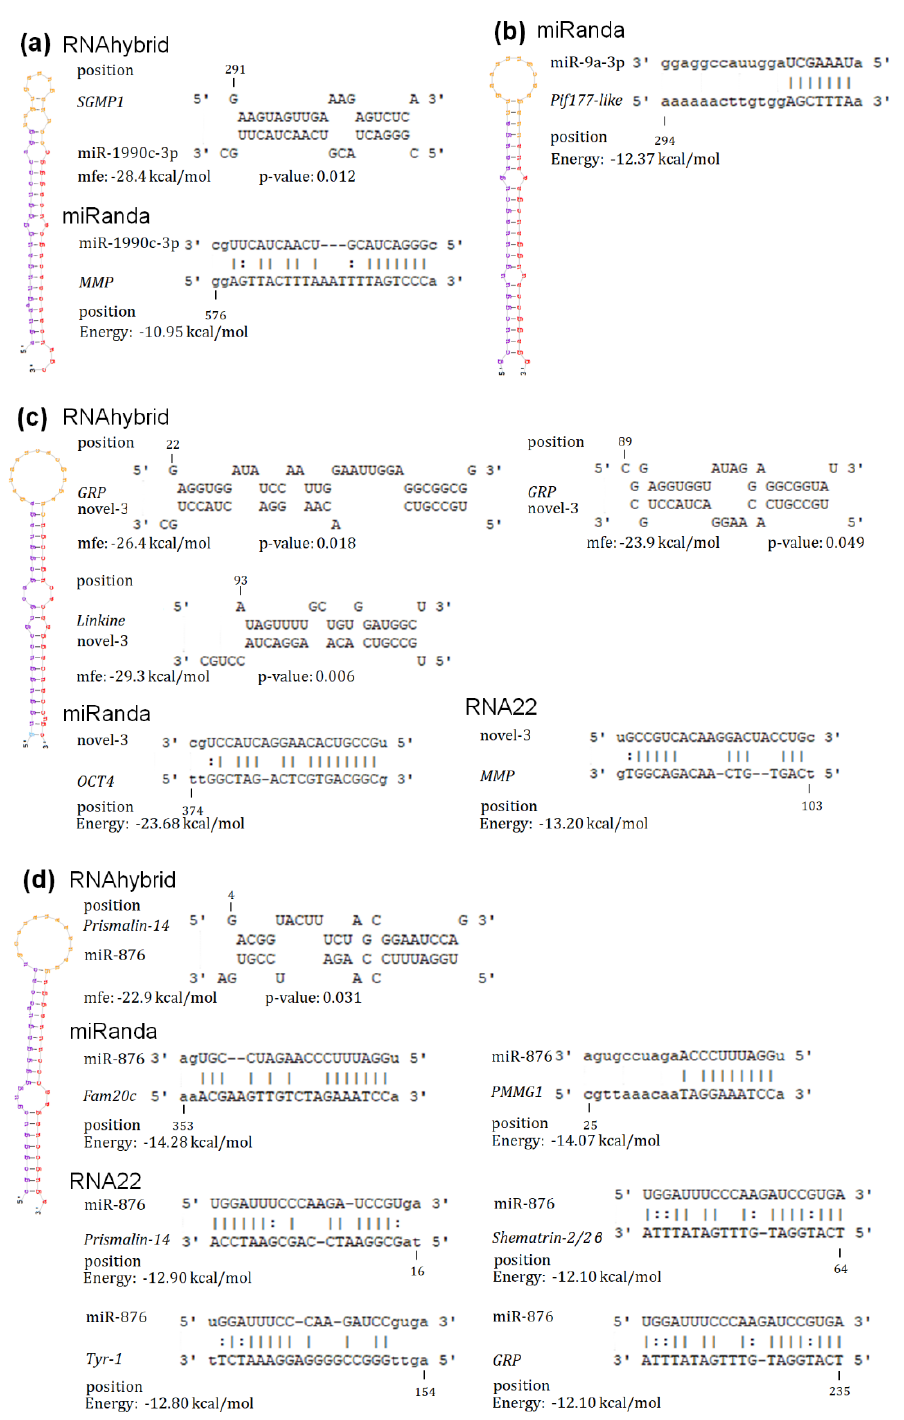
Figure 6. Hairpin structure of miRNAs and the potential target sites. ( a ) The potential target sites between miRNA-1990c-3p and MMP by miRanda, and between miRNA-1990c-3p and SGMP1 by RNAhybrid. ( b ) The potential target site between miR-9a-3p and Pif177-like protein by miRanda. ( c ) The potential target sites between novel-3 and GRP , between novel-3 and Linkine by RNAhybrid, and between novel-3 and OCT4 by miRanda, and between novel-3 and MMP by RNA22. ( d ) The potential target sites between miR-876 and Prismalin-14 by RNAhybrid and RNA22, and between miR-876 and Fam20c , between miR-876 and PMMG1 by miRanda, between miR-876 and GRP, between miR-876 and shematrin-2/ 2β , and between miR-876 and Tyr-1 by RNA22. The position of target genes is numbered from the 3'UTR starting position.